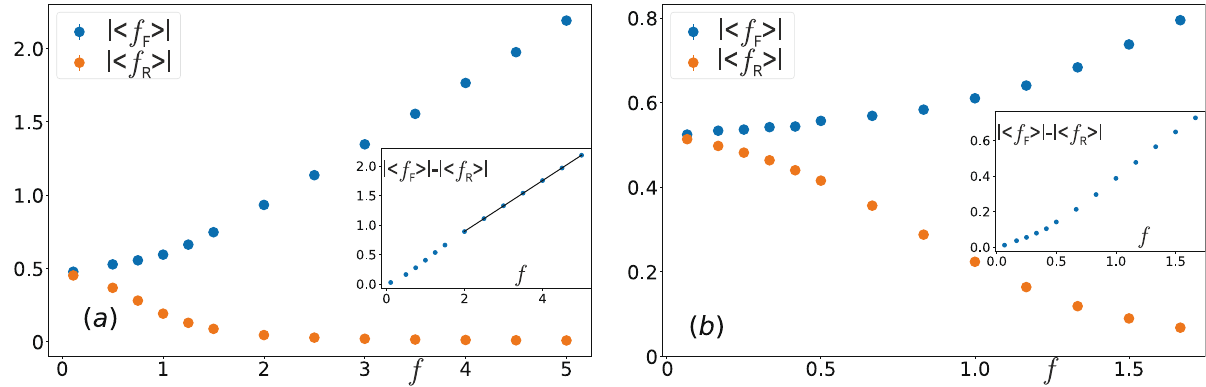
f F f R and exerted by active disks on the front and rear side |� �| |� �| f F f R versus f . |� �| − |� �|